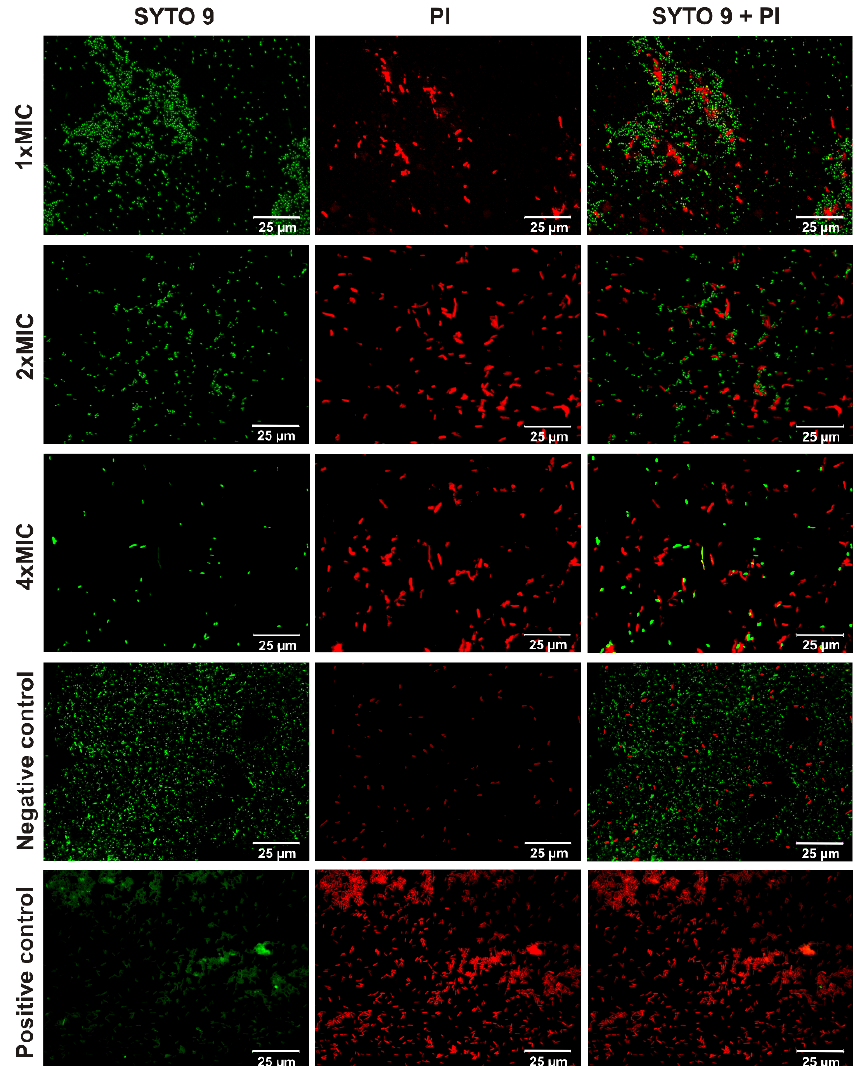
Figure 3. Fluorescence images of E. coli viability staining. Planktonic cell stained with SYTO9, PI and PI + SYTO9 treated with KK(K C16 )KK-NH 2 up to concentrations of 4, 8, and 16 µg/mL, corresponding to 1× MIC, 2× MIC, and 4× MIC, respectively, negative and positive controls. Green color indicates the bacterial cells with intact membranes, whereas red color indicates the bacterial cells with damaged membranes.